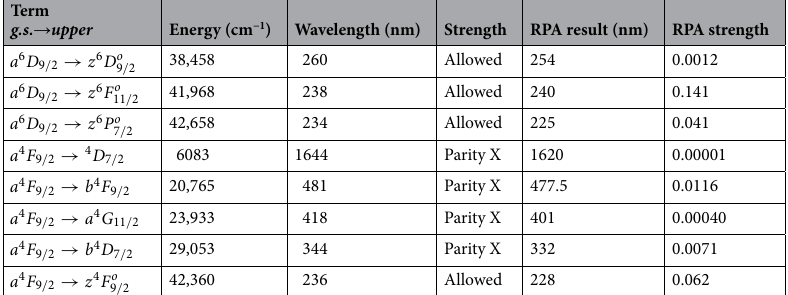
Table 2. List of Fe II transitions either forbidden due to parity ( parity X ) or fully allowed, compared to RPA results for averaged cases 3, 6 and 9 of Table 1 involving R(D) hydroxy-glycine residues with C-termini on Fe.